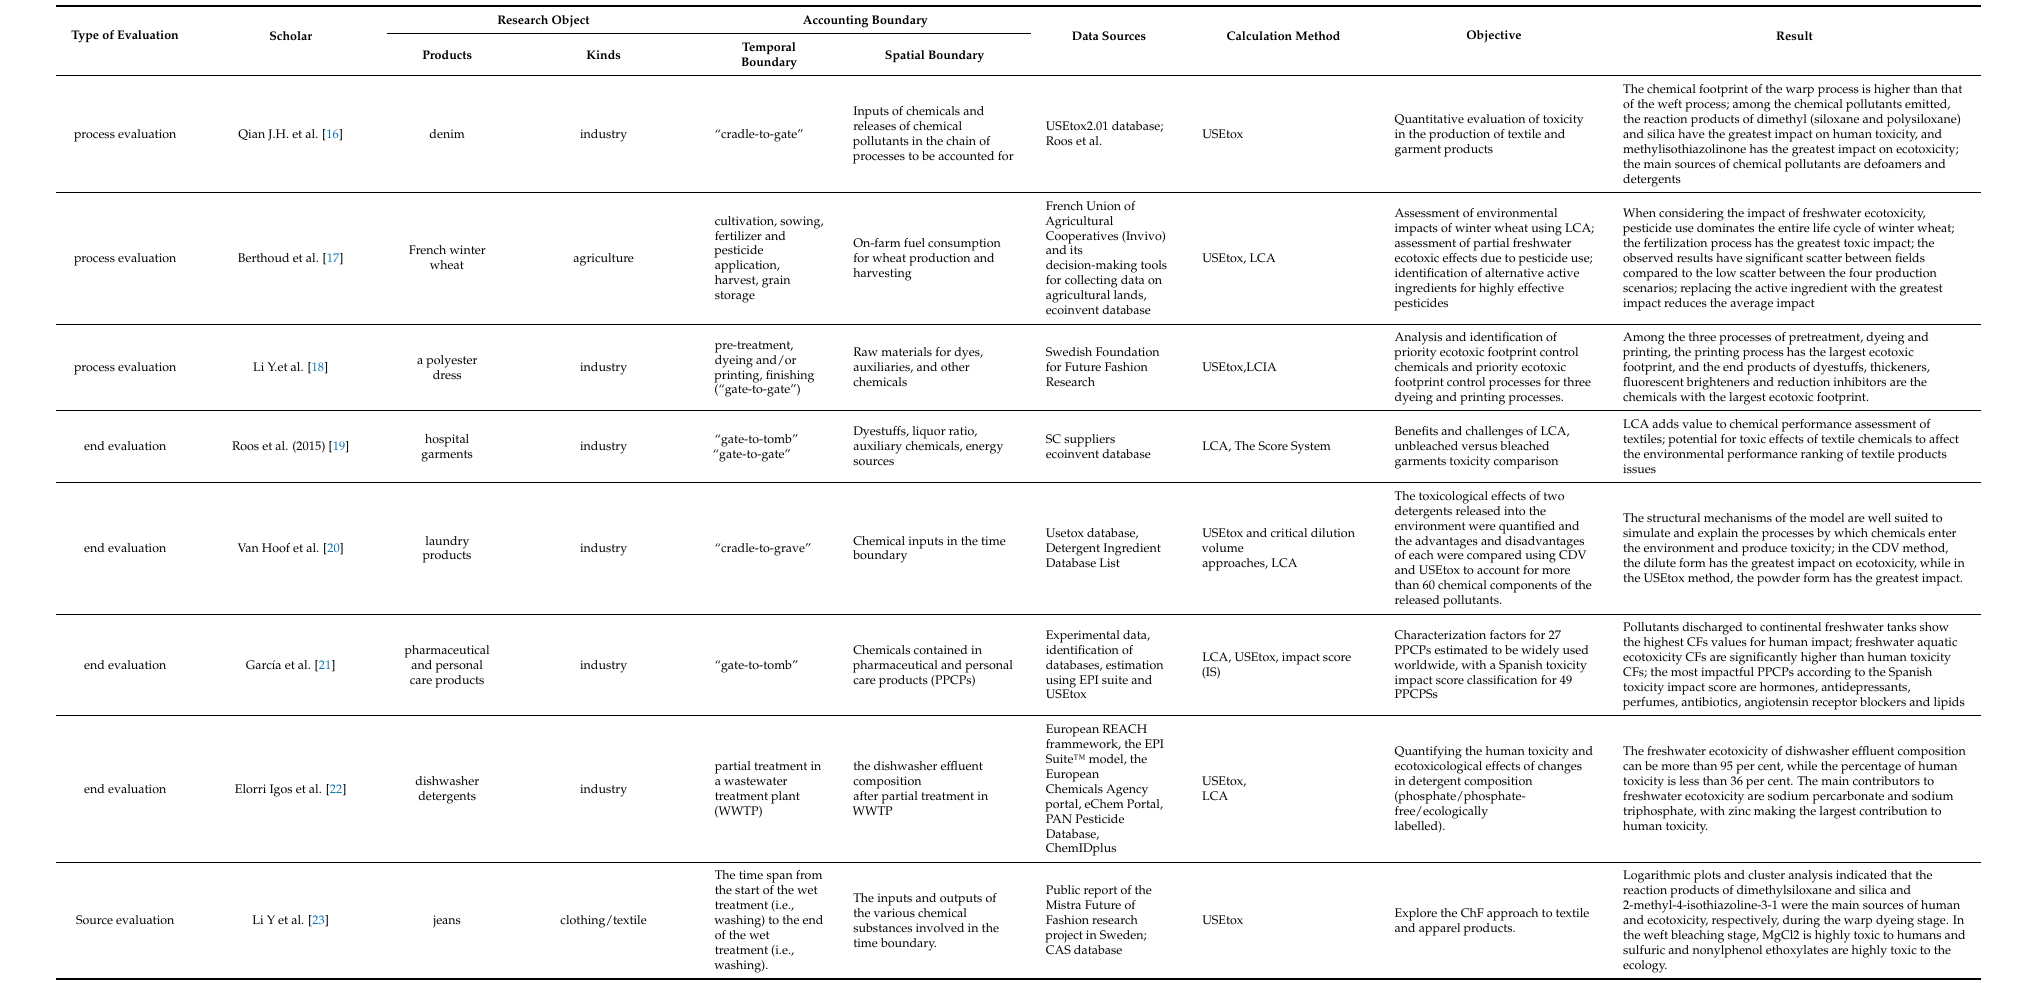
Table 1. List of key results and characteristic classification of product chemical